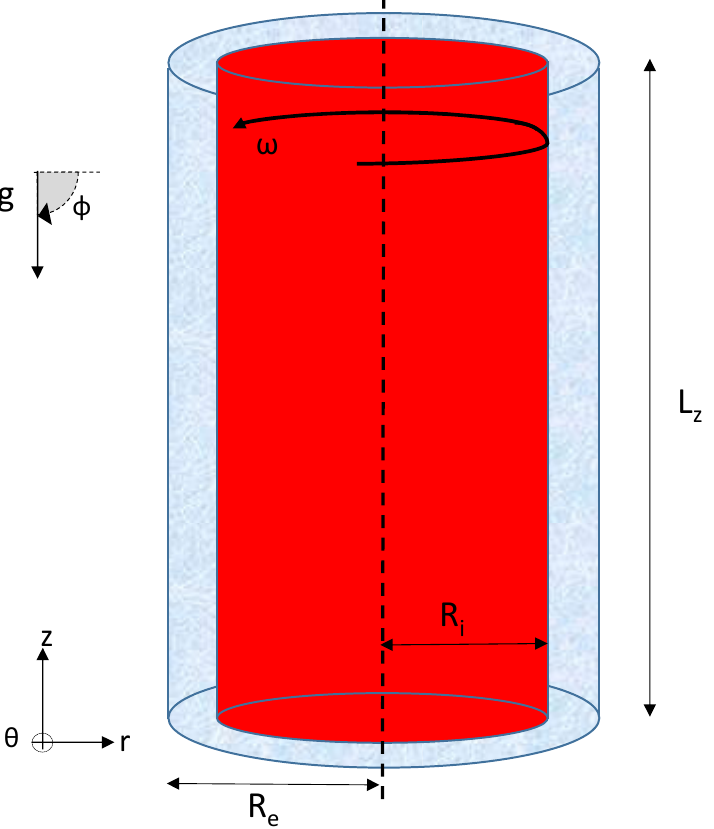
Figure 1. Position of the problem: two concentric cylindrical surfaces of internal and external radius, Ri and Re, and of length, L z , are inclined at an angle ϕ with gravity. The rotation is exerted from the inner cylinder (drawn here) at an angular velocity, ω . The heat density flux can be imposed from any wall surface (the inner cylinder is chosen here) while the fluid motion is flowing into the gap: e = Re − Ri .